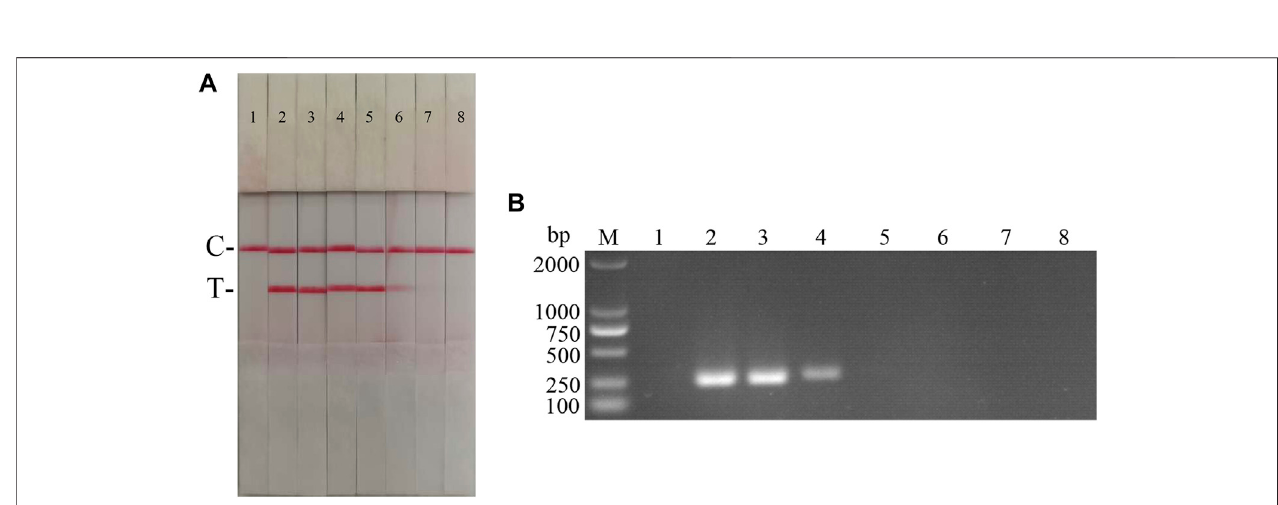
FIGURE 5 | DNA sensitivity analysis of the ASFV RAA-strip assay. (A) The sensitivity test result of ASFV DNA by ASFV RAA-strip in order. (B) was that by the conventional PCR assay. C is a control line. T is a test line. M is a 2,000 bp DNA marker. The templates used in lane 1 – 8 successively are: negative control, 100 μ